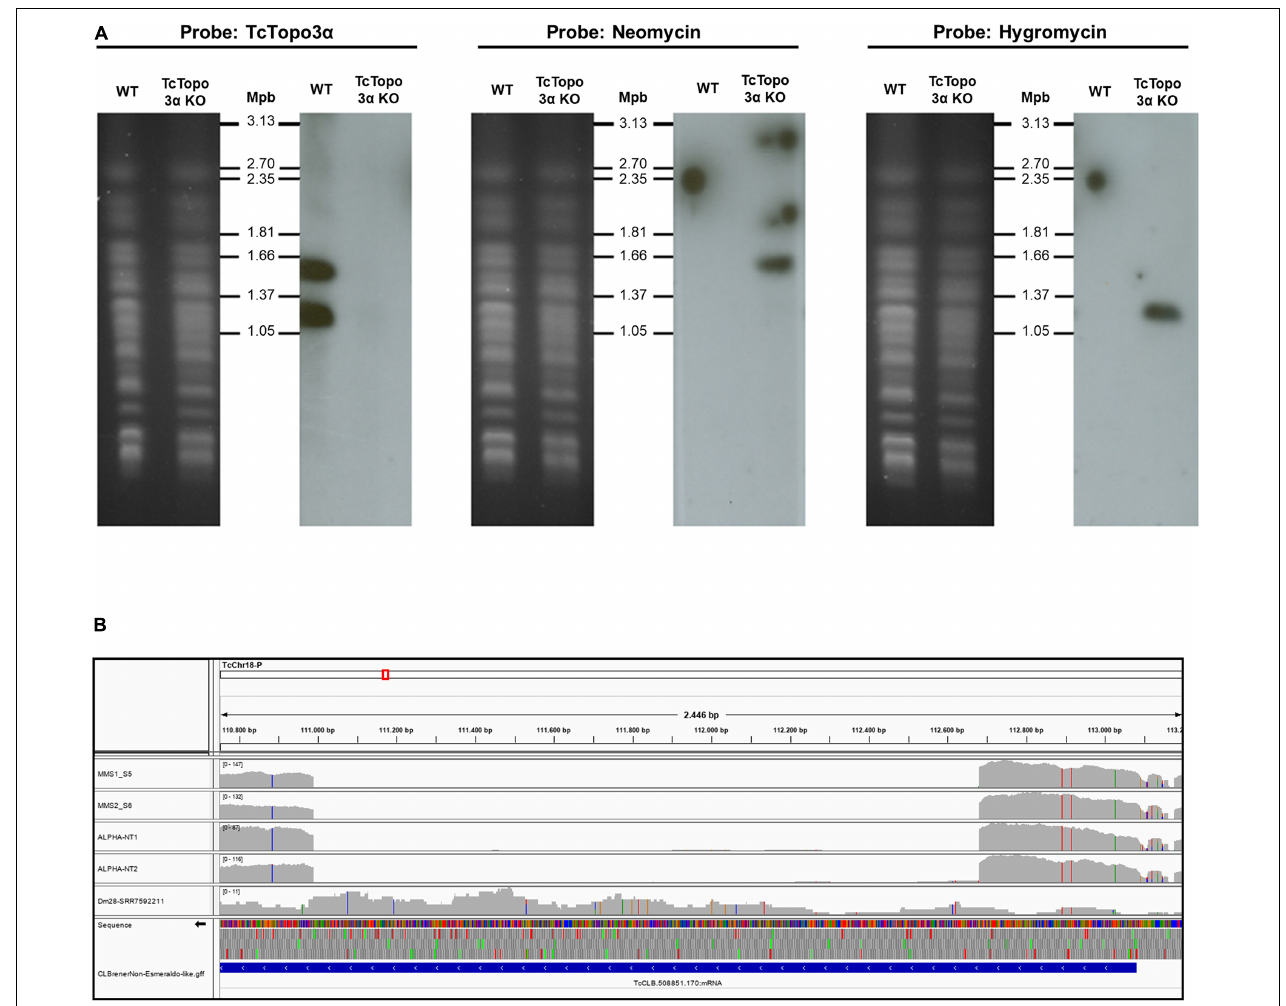
FIGURE 1 | Confirmation of topoisomerase 3 α gene knockout. (A) Southern blot analysis of WT and Topo3 α KO parasites. The chromosomes of WT and knockout epimastigotes were separated by pulsed-field gel electrophoresis (PFGE) (panels on left), transferred to nylon membranes, and hybridized with radioactive probes for TcTopo3 α , neomycin, or hygromycin resistance genes (panels on right). Chromosomes from yeast Hansenula wingei (1.05 to 3.13 Mbp) were used as molecular weight marker (Bio-Rad). It shows that TcTopo3 α probe recognized bands only in WT parasites while neomycin and hygromycin probes hybridized with bands only in TcTopo3 α KO parasites. It indicates that both TcTopo3 α alleles were replaced by deletion cassettes in selected parasites. (B) TcTopo3 α gene knockout confirmed by whole genome sequencing (WGS). In this integrative genomics viewer (IGV) image, the CL Brener Chr18 region that contains the TcCLB.508851.170 (TcTopo3 α gene) is represented. The MM1, MM2, NT1, and NT2 boxes represents the read depth in these isolates, showing the absence of reads in the TcTopo3 α gene central region. The Dm28 SRR7592211 box corresponds to the read depth in this isolate (obtained in NCBI), in which the TcTopo3 α gene was not deleted. In these four boxes, gray bars correspond to the read depth in positions in which the reads were similar to the CL Brener reference genome, while blue, red, green, and orange bars correspond to a nucleotide change to, respectively, “C,” “T,” “A,” and “G.” The TcCLB.508851.170 gene region is represented by a blue box in the CL BrenerNon-Esmeraldo-like-gff